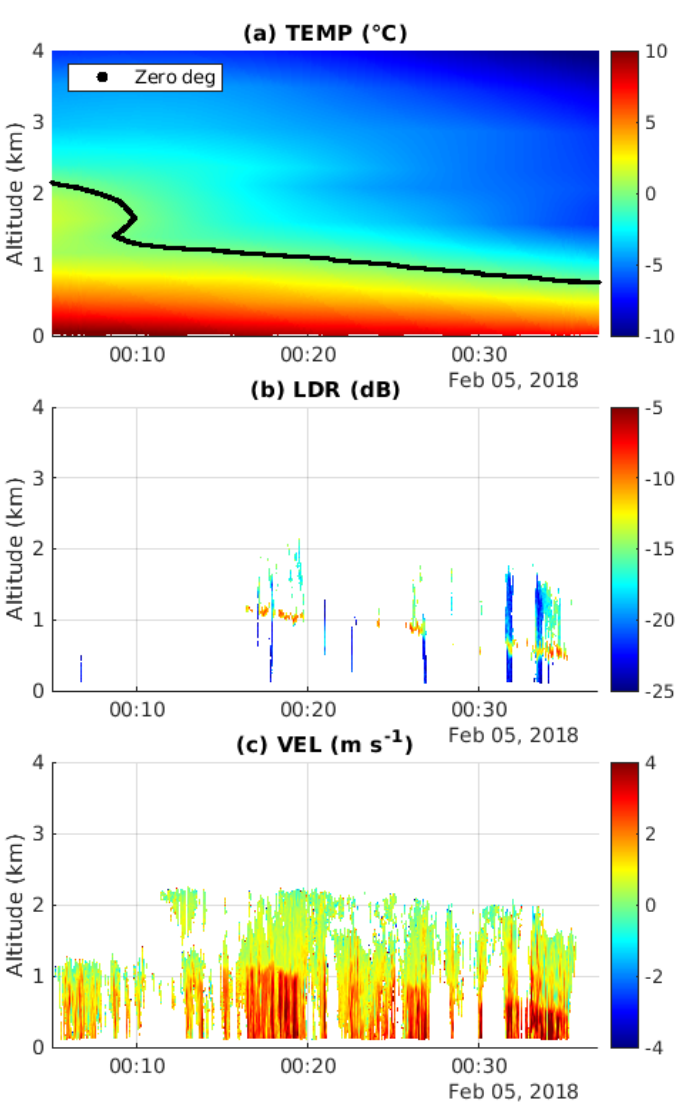
Figure 1. Input variables for the melting layer detection algorithm: ( a ) ERA5 temperature (TEMP) with 0 °C isotherm (black line), ( b ) linear depolarization ratio (LDR), and ( c ) radial velocity (VEL, positive values indicate downward motion). Times are in UTC.